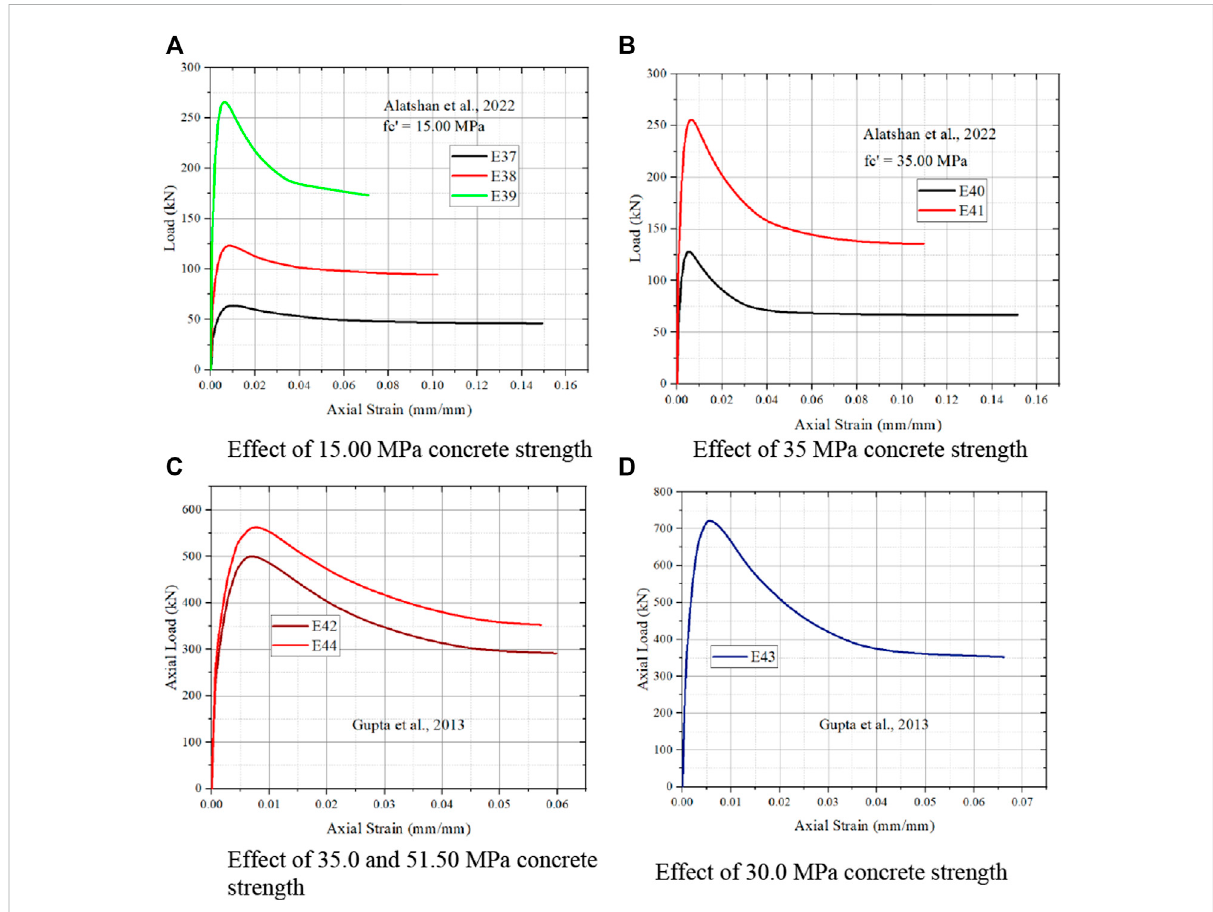
FIGURE 9 Effect of different concrete strength from (Gupta et al., 2020; Alatshan et al., 2022 and Gupta, 2013). (A) Effect of 15.00 MPa concrete strength. (B) Effect of 35 MPa concrete strength. (C) Effect of 35.0 and 51.50 MPa concrete strength. (D) Effect of 30.0 MPa concrete strength.